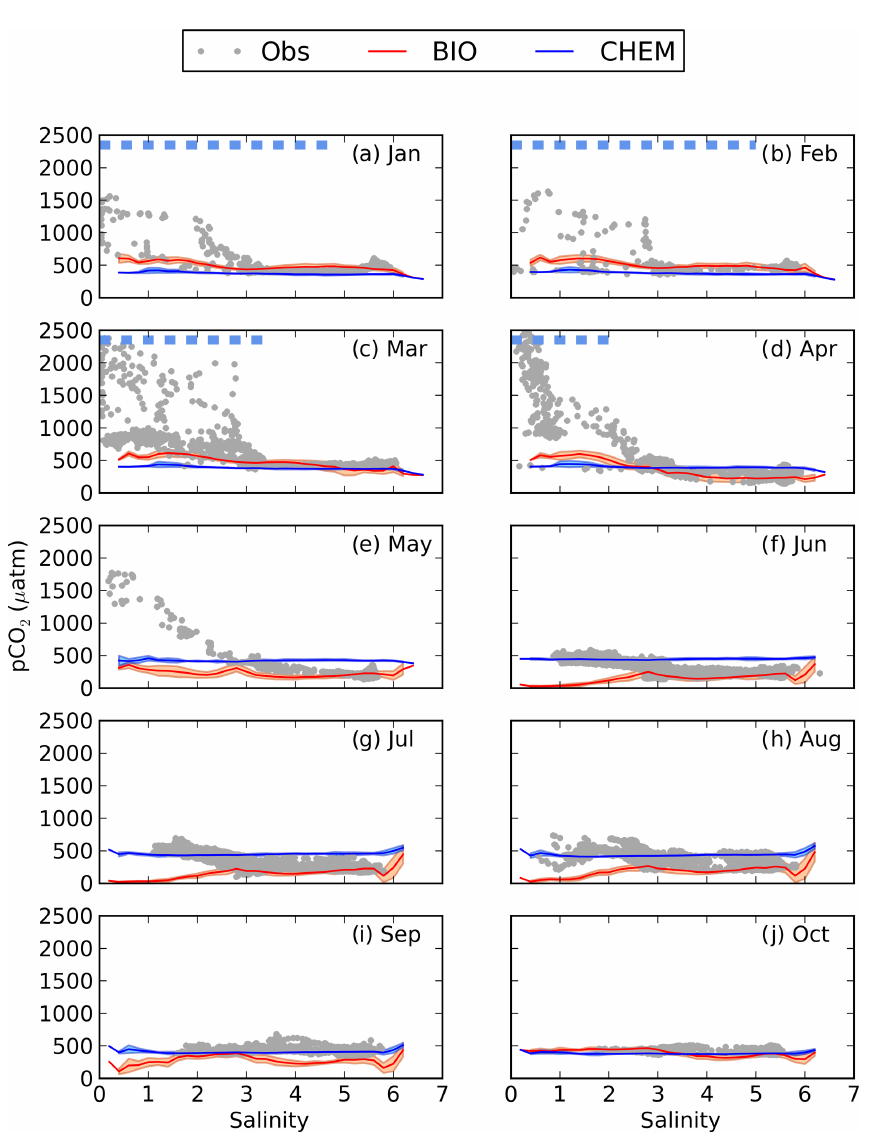
Figure 4. p CO 2 –salinity relationships for January–October ( a–j ). Grey dots show observed values. The red and blue lines show modelled climatological monthly means for the BIO and the CHEM experiments, with the shaded area displaying the standard deviation at a given salinity. The dashed blue line shows the ice extent (salinities at which the ice concentration is larger than